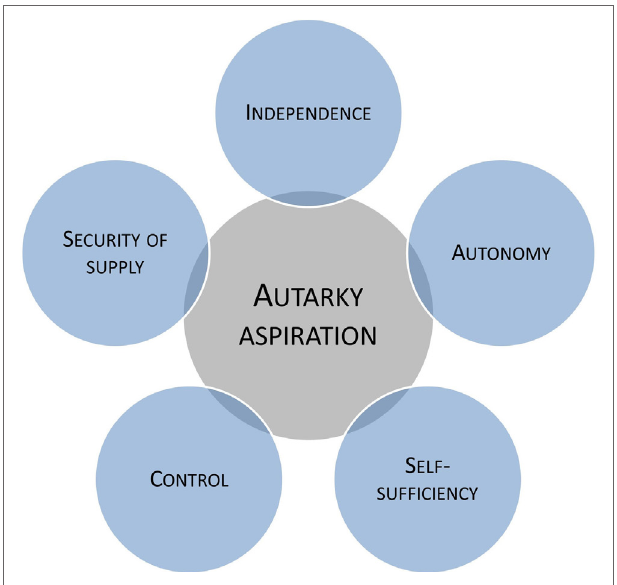
FigUre 7 | Psychological components of autarky